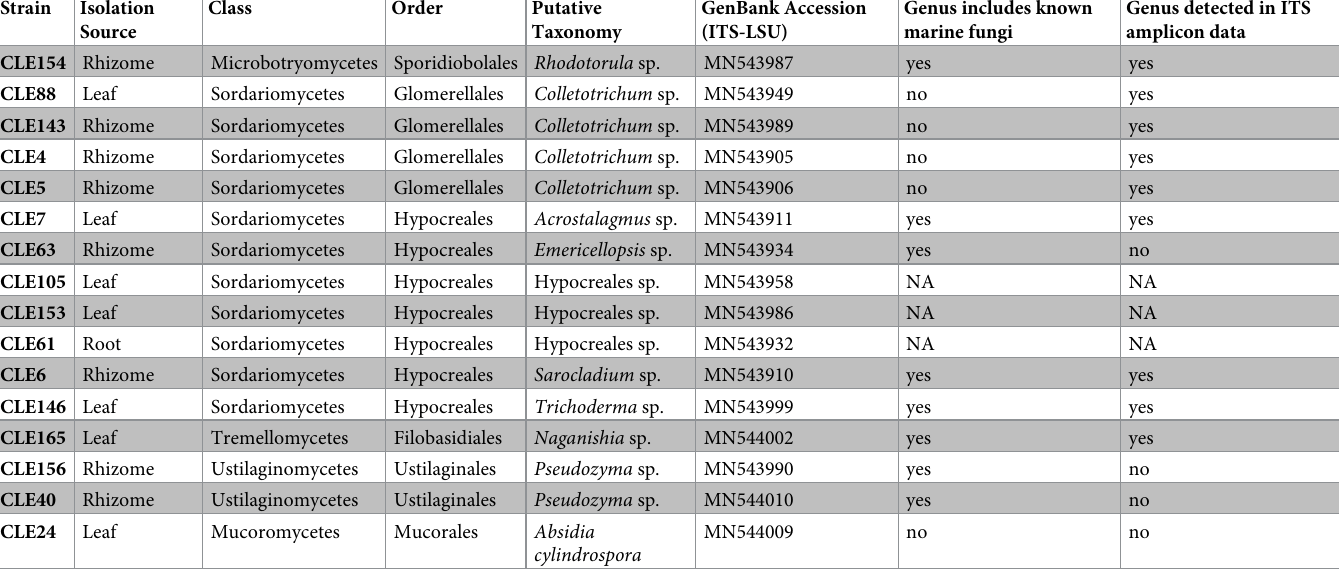
with 614 positions (Basidiomycota / Mucoromycota), 91 sequences with 509 positions (Euro- tiomycetes), 96 sequences with 501 positions (Sordariomycetes), and 107 sequences with 563 positions (Dothideomycetes). F81, K80/HKY, SYM/GTR) and then otherwise default parameters on the CIPRES Science Gateway web server to select a best-fit model of nucleotide substitution for use in phylogenetic analyses for each alignment [79, 80]. The best-fit model based on the Akaike Information Cri- terion values for all alignments was the GTR + I + G evolutionary model. Using the CIPRES Science Gateway web server, Bayesian phylogenetic inference for each